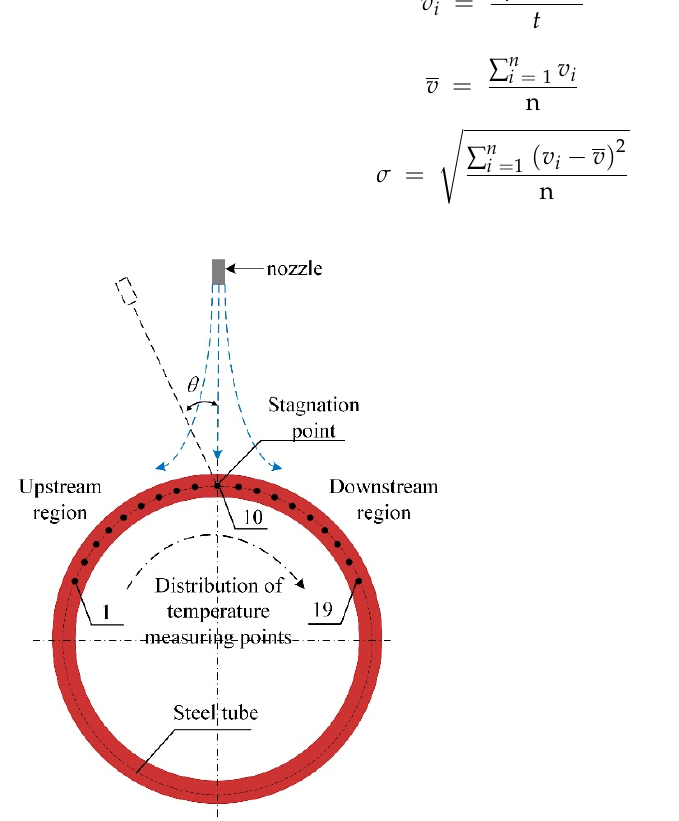
Figure 10. Schematic diagram of temperature measurement point distribution of a steel tube.